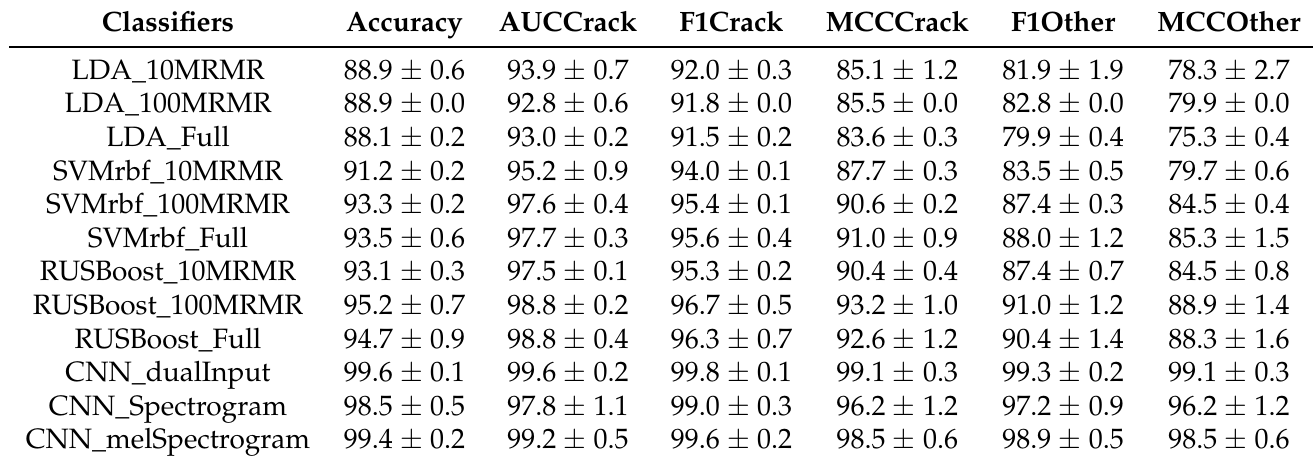
Table 9. Performance results obtained with 2 classes (crackle vs. other)—training: fixed duration; testing: fixed